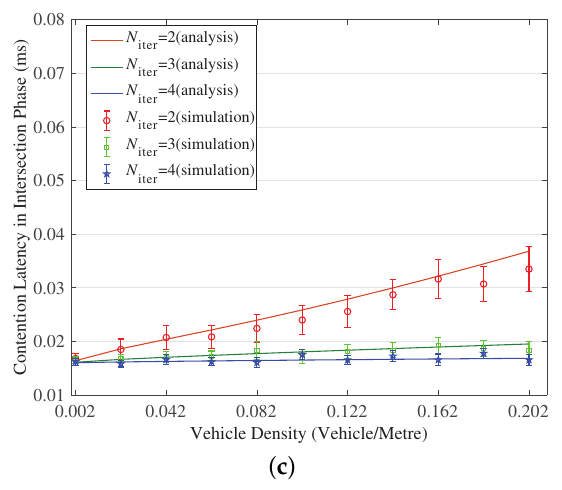
Figure 4. Validation of the model for contention latency in Intersection Phase. ( a ) When ( N iter , N part ) =(2,3); ( b ) When ( N iter , A ) = ( 2,2 ) ; ( c ) When ( N part , A ) = ( 4,2 ) .